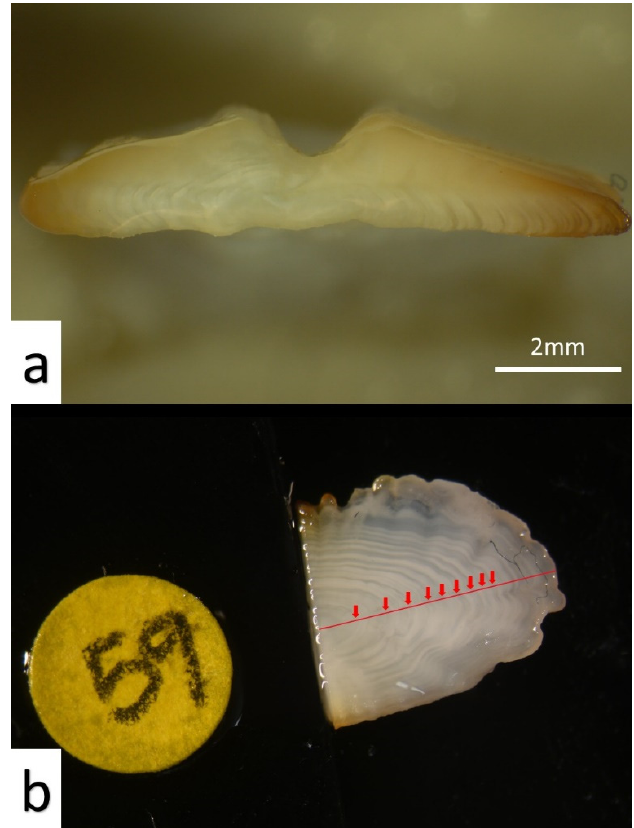
Figure 2. ( a ) Transverse cross section of otolith from S. maliger . This view was used to count presumptive annuli for an age estimate (photo by Andrew Suchomel). ( b ) Photograph of convex surface of the otolith (sagitta) used to measure the distance from the core of presumptive annuli for ages 1–9 (red arrows) along the longest axis (red line; photograph by Camron Christoffersen). Otoliths pictured in a and b do not belong to the same individual.